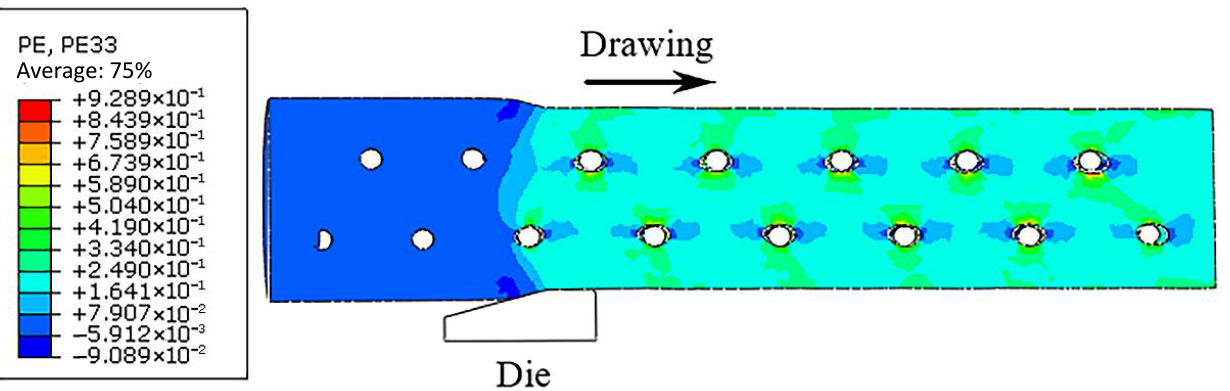
Figure 6. Strain distribution in drawing.